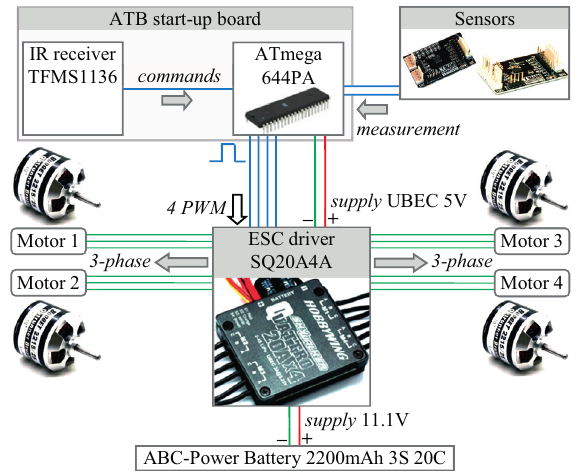
Fig. 18. A schematic view of the connections between main components of the control